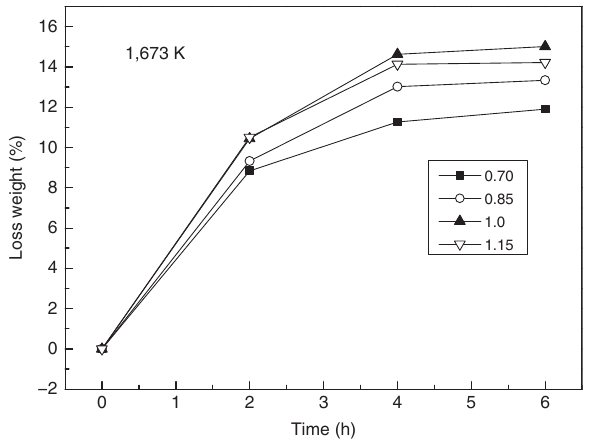
Figure 5: The percentage of total mass loss with different carbon ratios at 1,873 K.